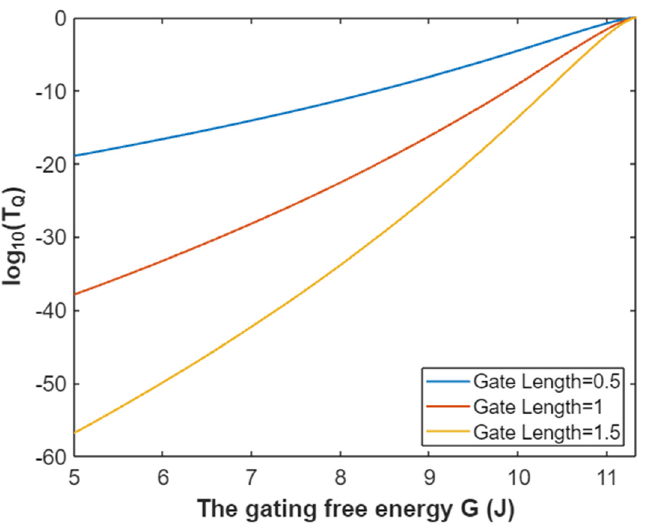
Figure 23. The relationship between gating free energy and the common logarithm of tunneling probability of extracellular potassium ions at membrane potential of 0.087 V and over a gating free energy range from 5 J to 11.33 J.